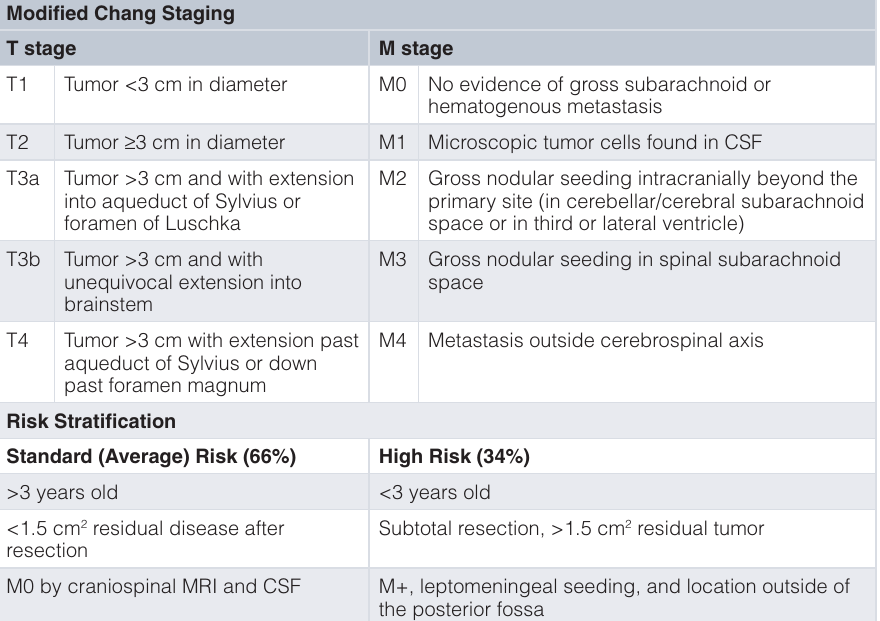
Table 2. Staging and risk stratification of medulloblastomas.